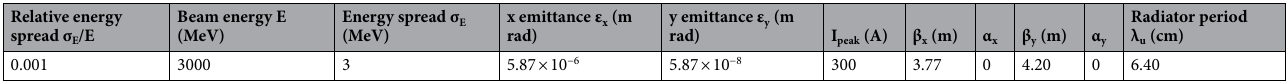
Table 2. NSLS-II lattices and beam parameters include the Twiss at the short straight section and the RMS beam energy spread and normalized emittances. *Normalized emittances are used.